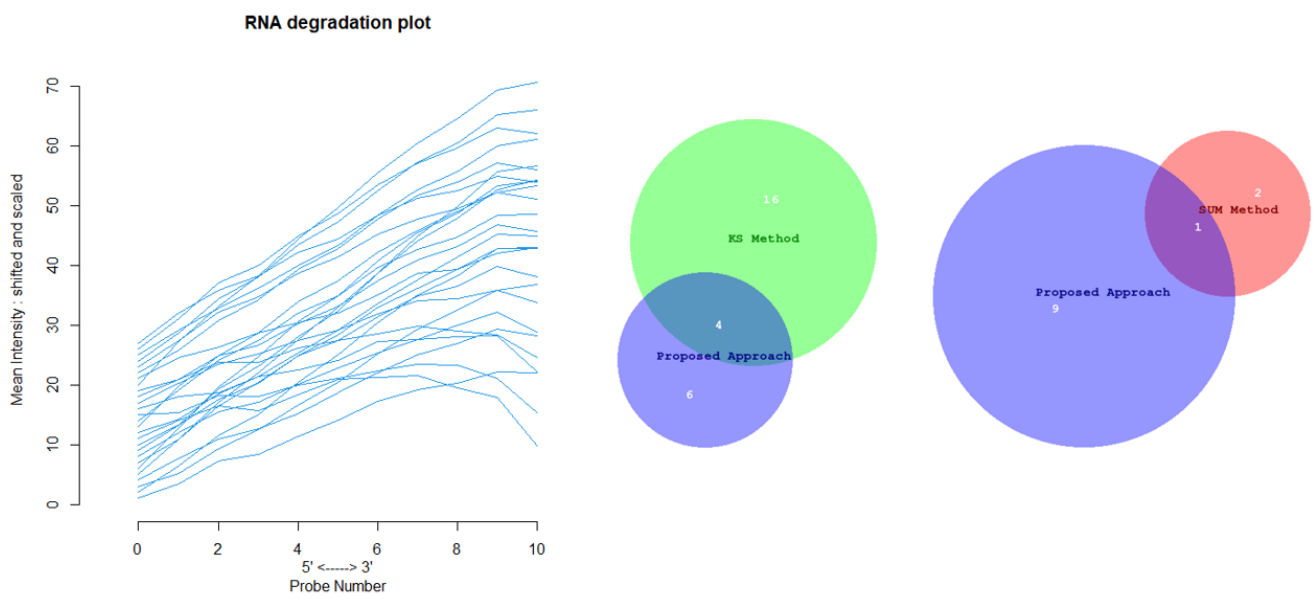
Figure A5. Datset C: ( left ) outlier degradation plot of detected outliers and ( right ) Euler-Venn diagrams comparing the results obtained by three outlier detection